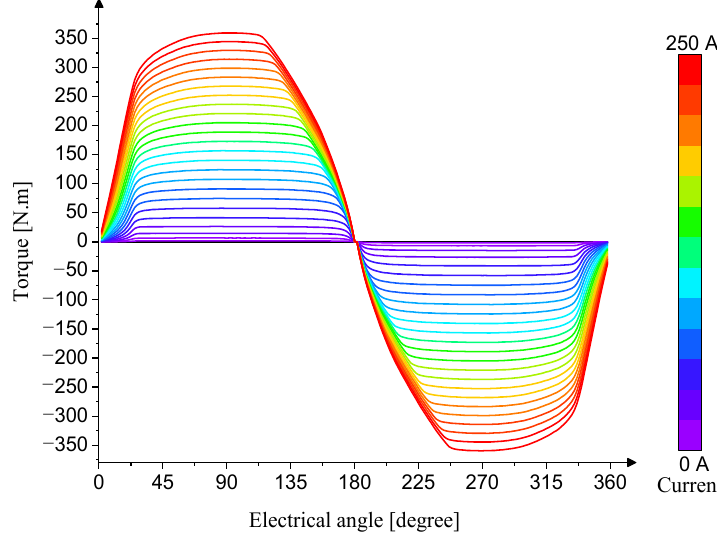
Figure 21. Static electromagnetic torque for different current references.